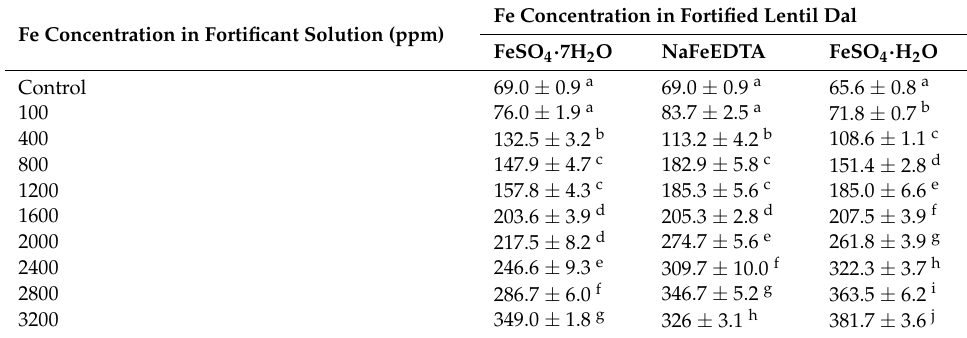
Table 1. Fe concentration (ppm) in polished football lentil dal samples prepared using three fortificants (FeSO 4 · 7H 2 O, NaFeEDTA and FeSO 4 · H 2 O) at concentrations ranging from 100 to 3200 ppm.